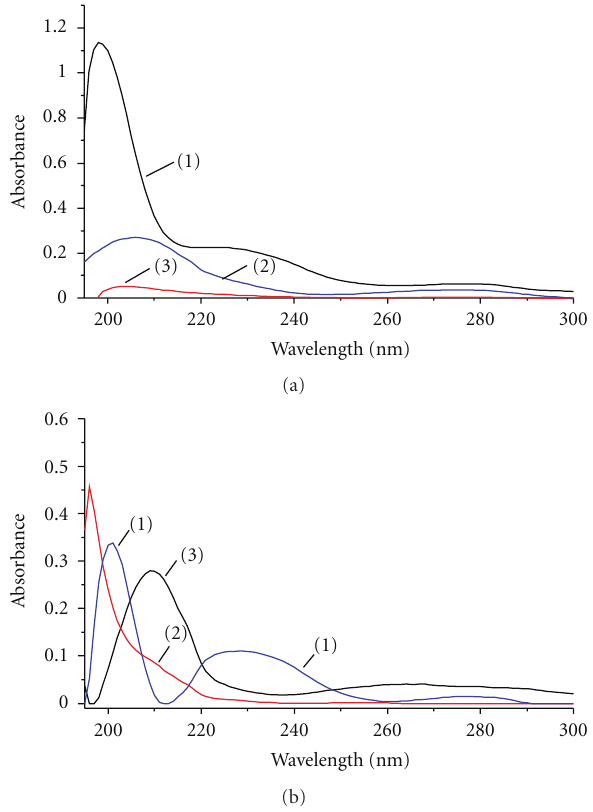
Figure 1: Absorbance spectra of surrogate alcohol (1) (1/150 dilu- tion), samogon (2), and vodka (3) (dilution 1/10) (a); results of MCR application for spectra of alcoholic beverages: DEP (1), PHMG (2), and interference (3)